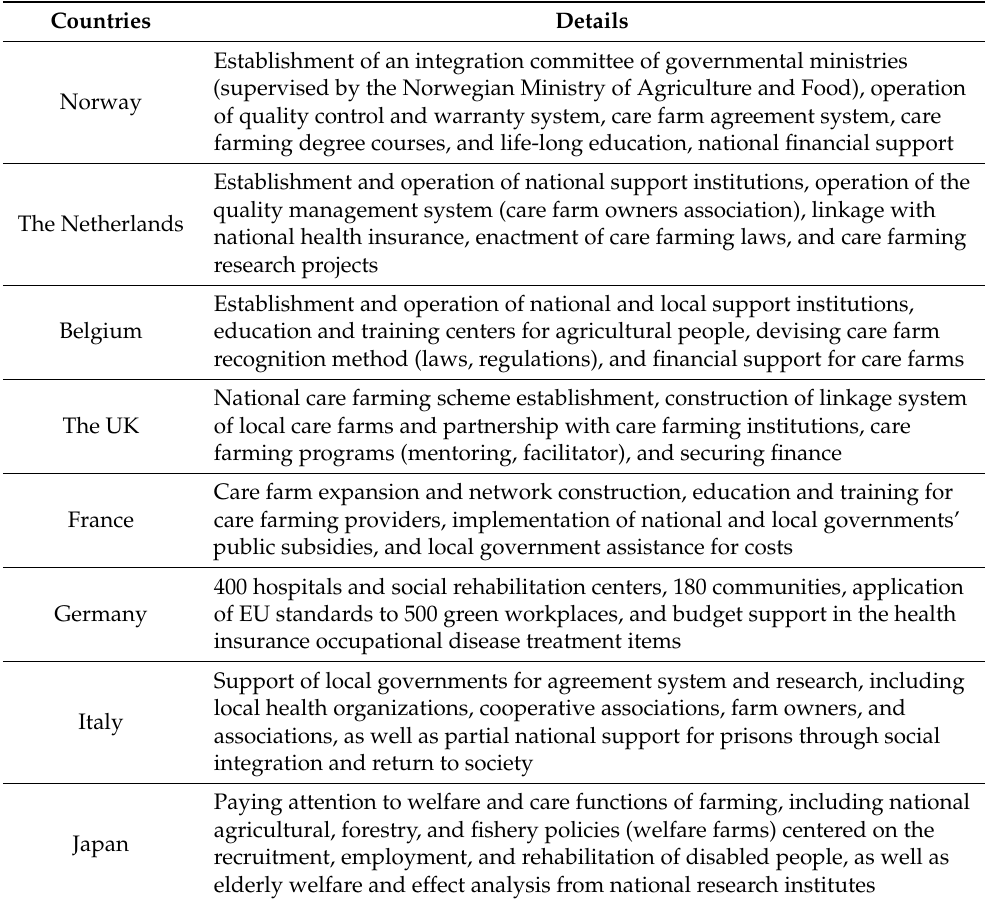
Table 1. Details of development countries’ care farming